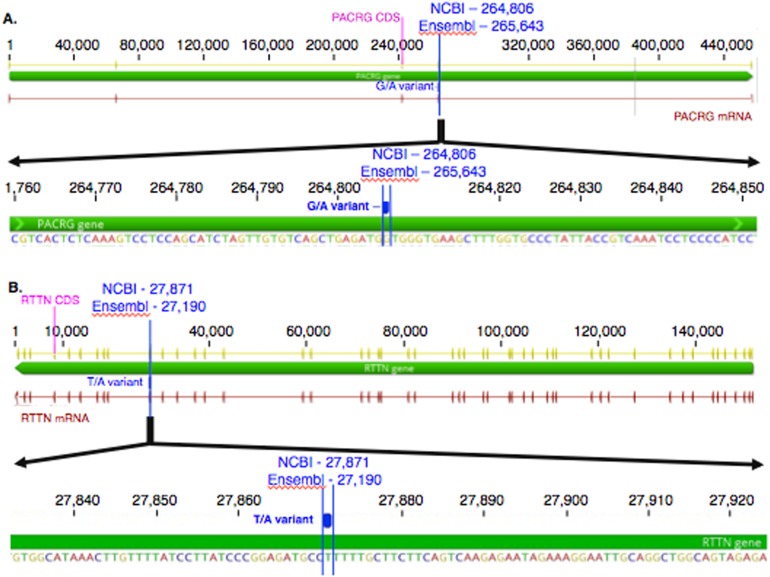
Substitution variants in PACRG (A) and RTTN (B) genes.Diagrams show position of gene (thick green line), mRNA (red line) and coding region (yellow line). The whole gene is outlined at the top and details of the nucleotide sequence around the substitution variant are shown at the bottom. Location of the substitution variant is indicated in blue for NCBI and Ensembl databases.